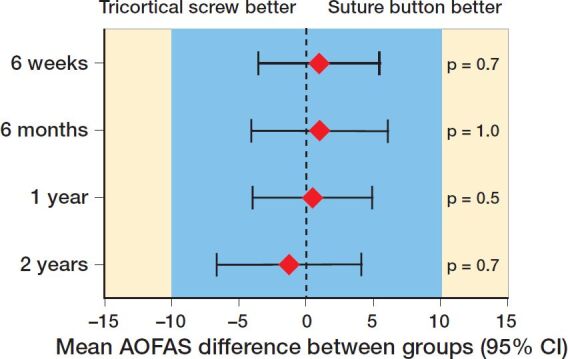
AOFAS equivalence diagram. Blue area indicates margins of equivalence defined as the between-group difference of 10 points. Results at all time intervals are equivalent since the 95% CI lies wholly inside the margins.